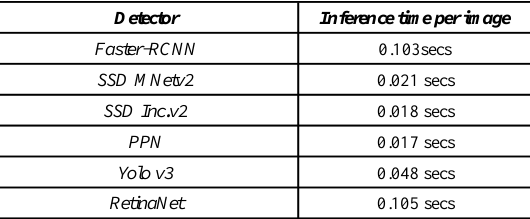
Table 4. Inference time of each OD